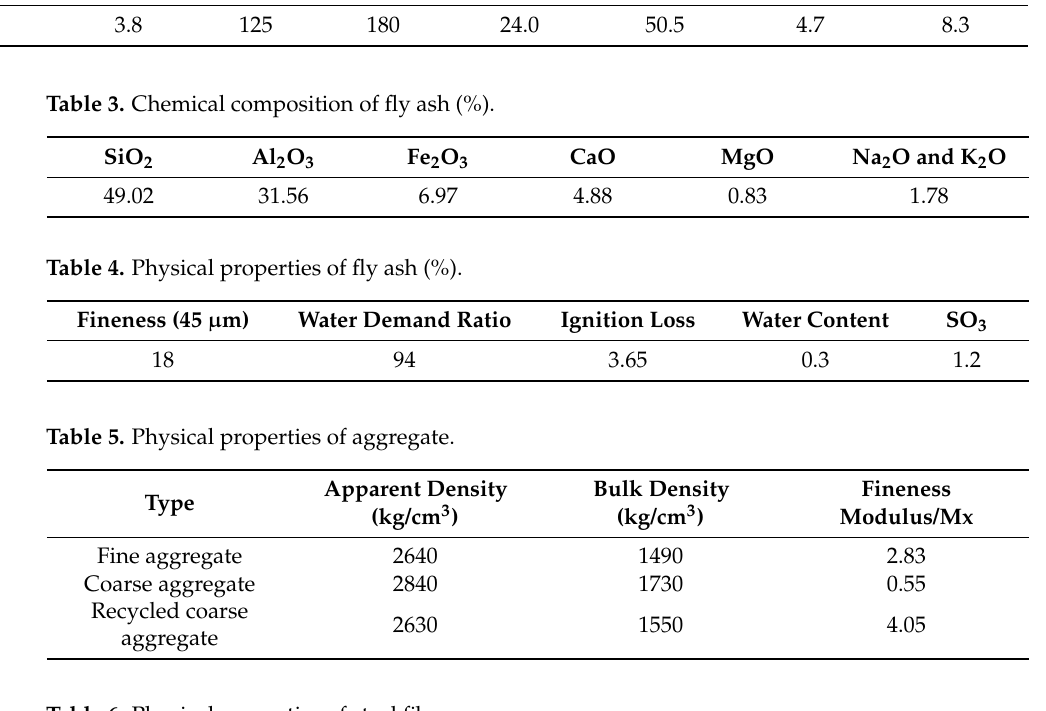
Table 6. Physical properties of steel